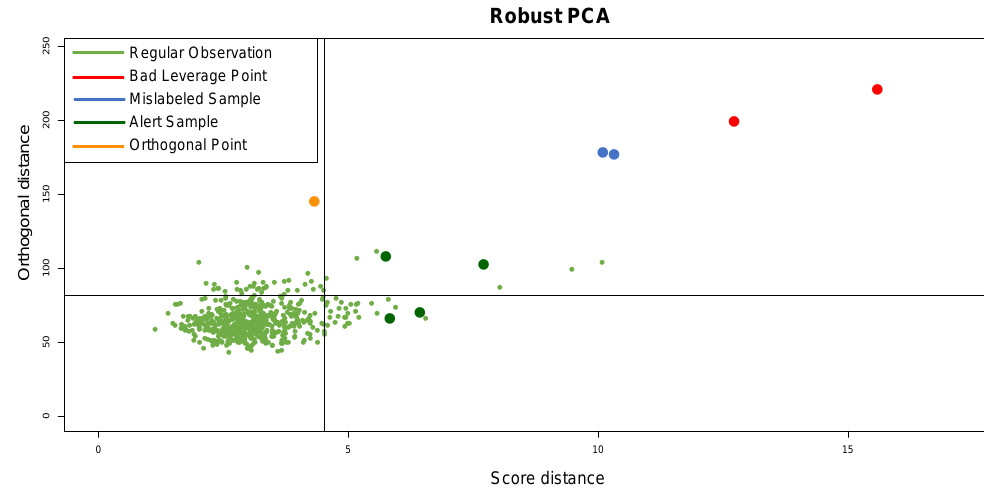
Figure 9. DD-plot of Dataset A. The two BLP s (in red ) and the two mislabeled samples (in blue ) are in the top-right quadrant, the OO (in orange ) are in the top-left quadrant, and some AS s ( dark green ) are on the border between the top-right quadrant and the bottom-right quadrant.